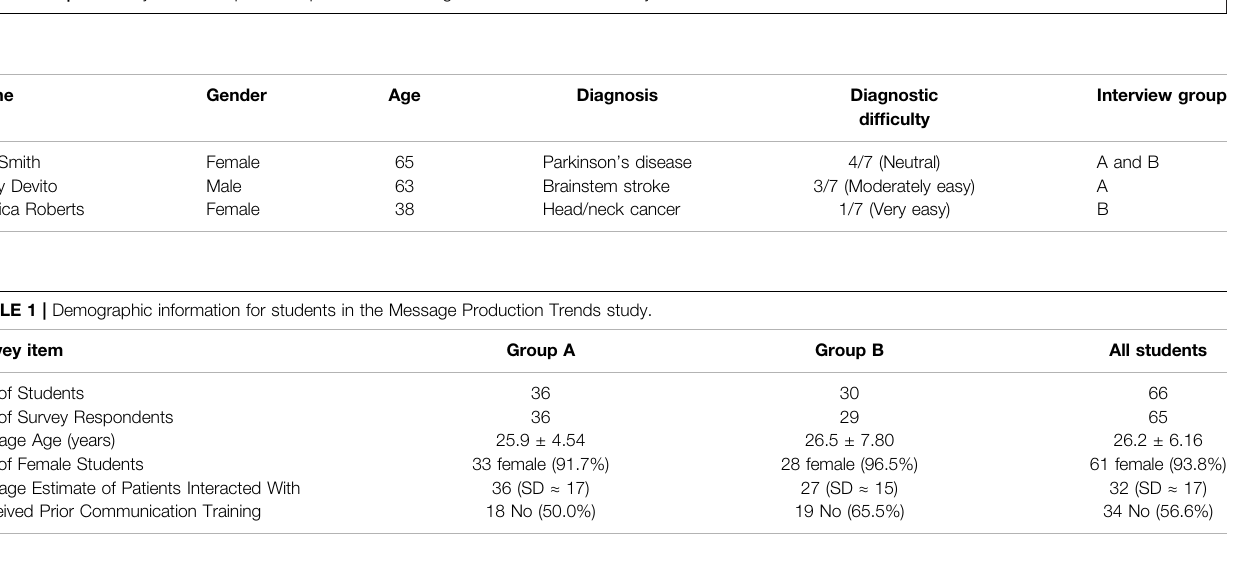
FIGURE 2 | The study tasks completed as part of the Message Production Trends study.